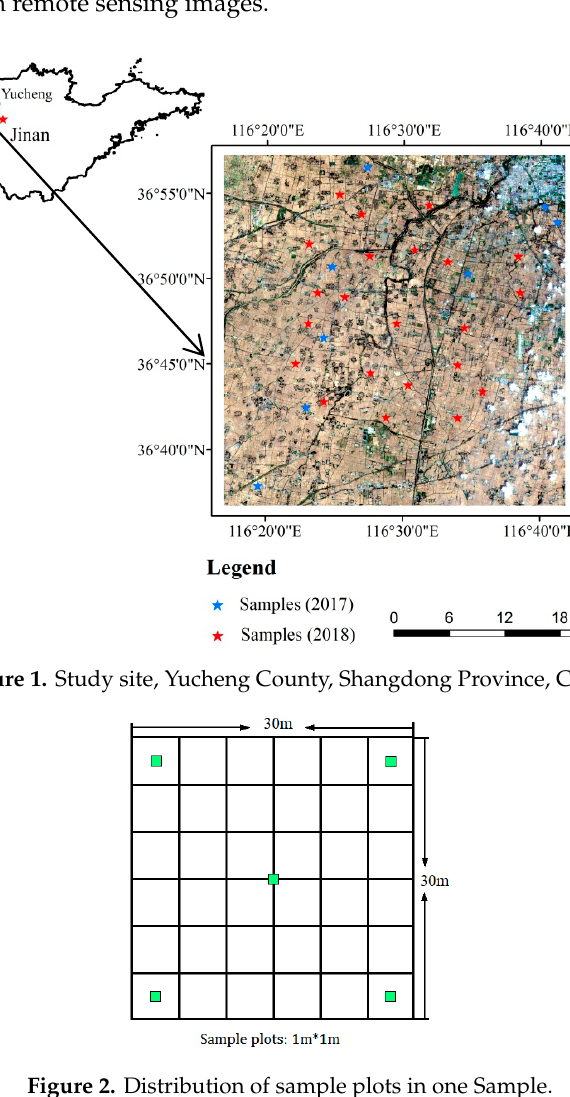
Figure 2. Distribution of sample plots in one Sample.